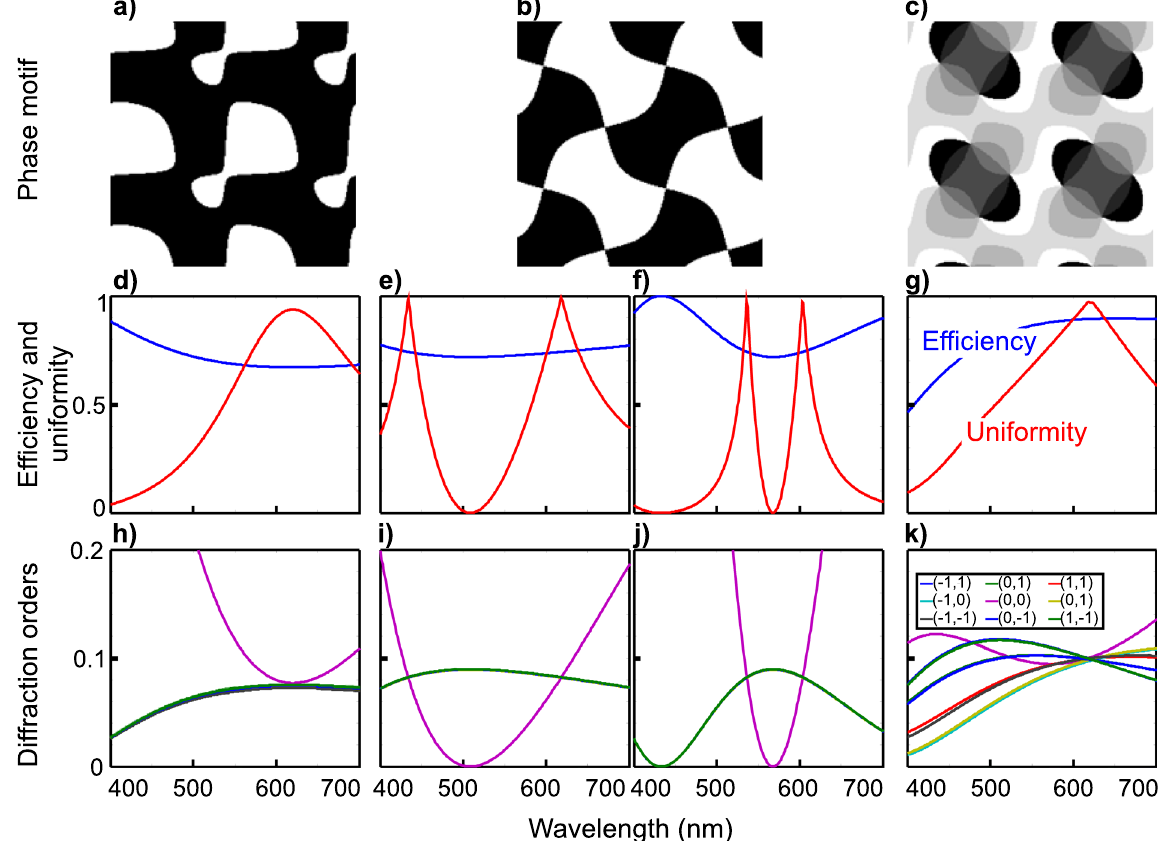
Figure 2. Influence of the wavelength on the diffraction performance. ( a – c ) Are the investigated 3 different gratings for generating 3 × 3 equal intensity diffraction orders array. ( a ) corresponds to binary phase shift of π , ( b ) 0.84 × π and ( c ) is an 8 phase grating. In ( d – g ) are presented the corresponding efficiency and uniformity as function of the wavelength while ( h–k ) details the different order intensities. The difference between ( e and i ) from one side and ( f ) and ( j ) on the other, is that the former are simulated for 0.84 × π phase shift and the latter are for 0.84 × π + 2 π